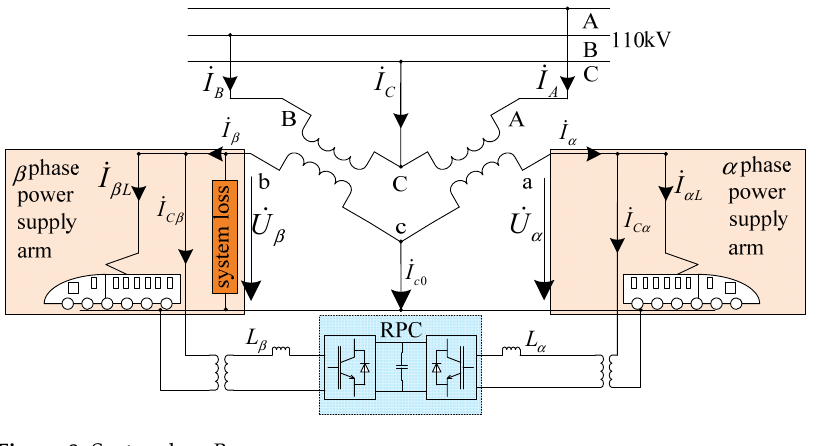
Figure 8. System loss P l .